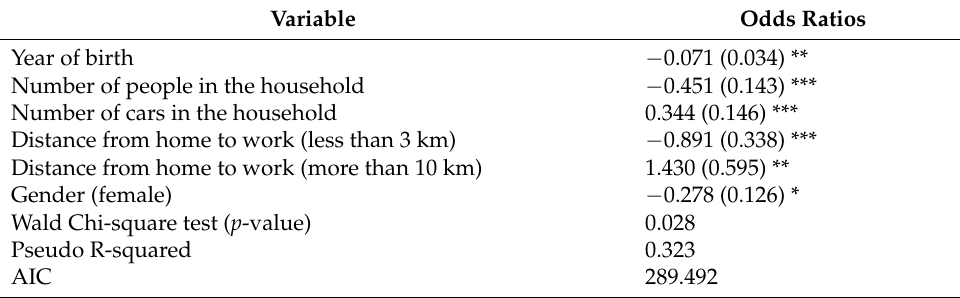
Table 9. Logistic regression model ( n =